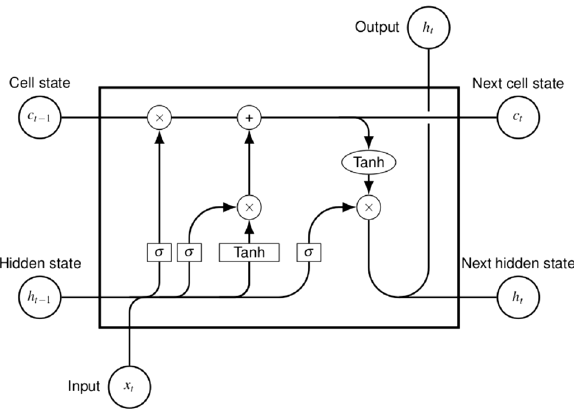
Figure 3. The long short-term memory (LSTM) model